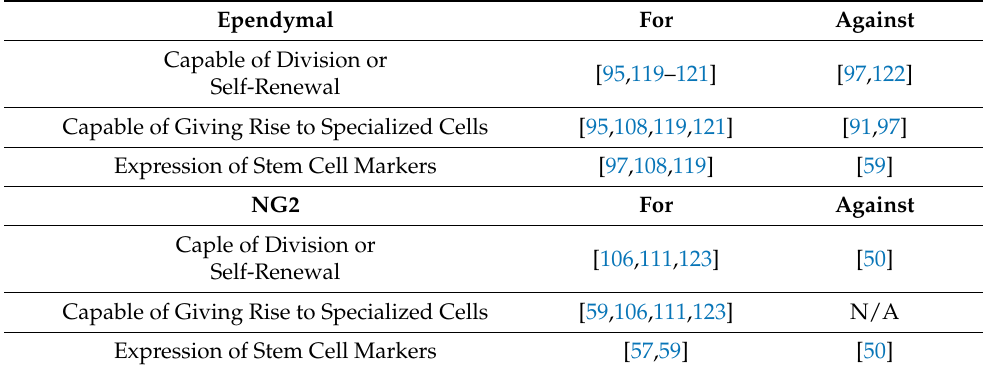
Table 2. Literature supporting or refuting NG2+ and ependymal cells as stem